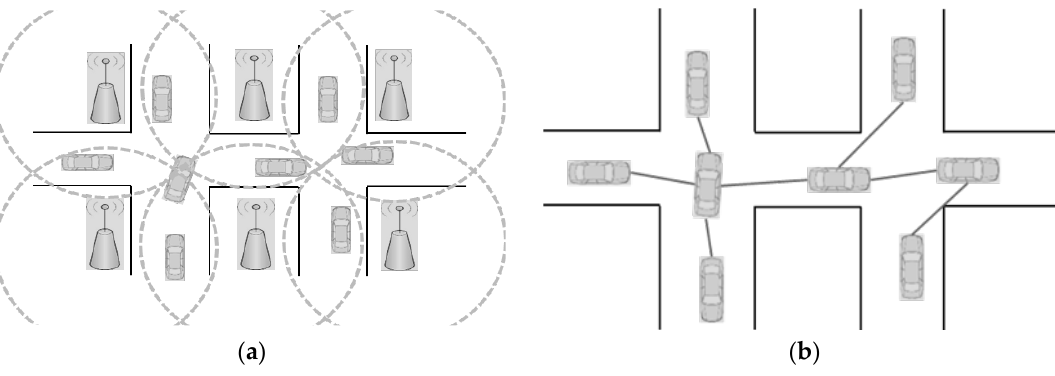
Figure 1. Different communication models in Vehicular Ad Hoc Networks (VANETs): ( a ) Vehicle-to-Infrastructure (V2I); and ( b ) Vehicle-to-Vehicle (V2V).